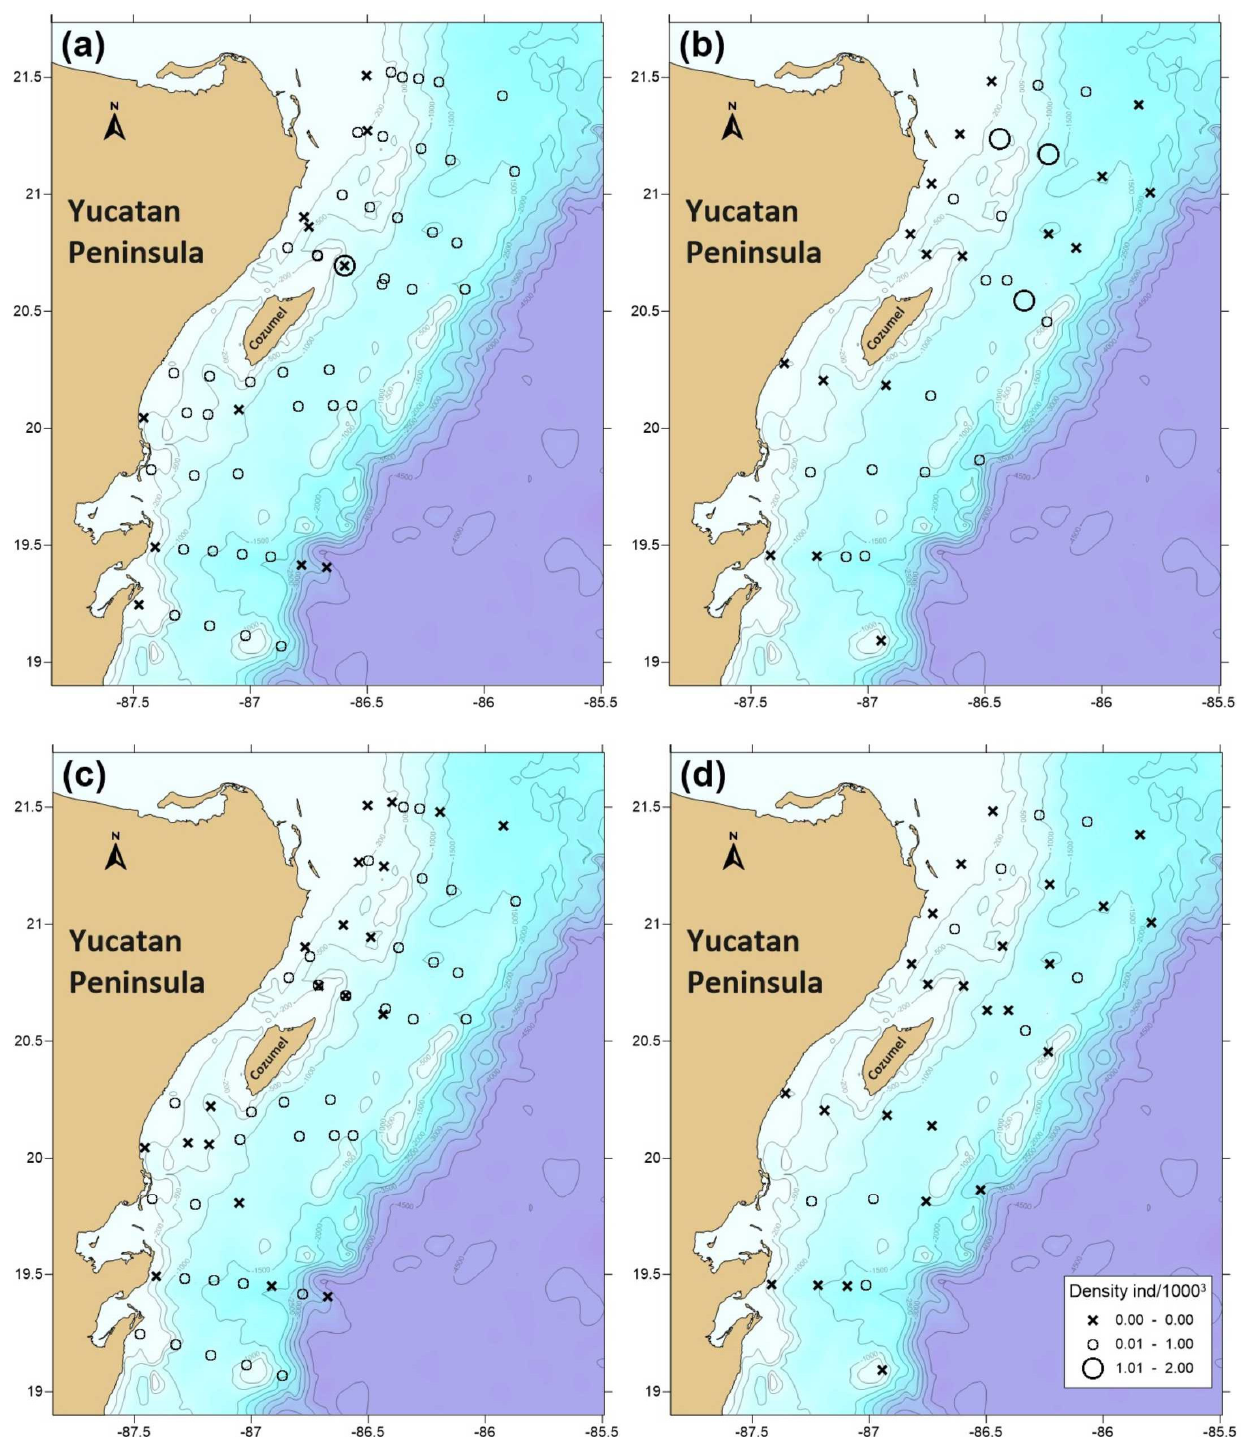
Figure 6. Density (number of larvae per 1000 m 3 ) of water of phyllosomata of Panulirus guttatus by sampling station. ( a ) mid-stage phyllosomata, autumn cruise; ( b ) mid-stage phyllosomata, spring cruise; ( c ) late-stage phyllosomata, autumn cruise; ( d ) late-stage phyllosomata, spring cruise. The scale is the same for all panels. Palinurellus gundlachi was the third most frequent species. In the autumn cruise, the mid- and late-stage phyllosomata of P. gundlachi appeared in 80% and 34.5% of the stations, respectively, with densities similar to those of P. guttatus (Figure 7a,b). The maximum values were 1.02 and 0.36 ind 1000 m − 3 , respectively. In the spring cruise, the mid- and late-stage larvae occurred in 23.5% and 38.2% of the stations, respectively, with higher